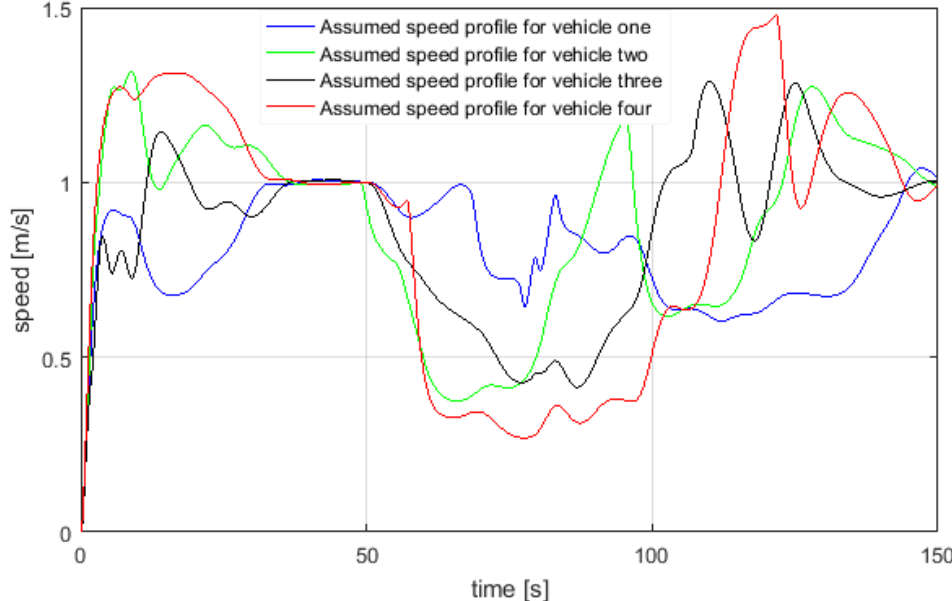
Figure 16. USV speed profiles assumed during swarm aggregation evolution for four USVs.